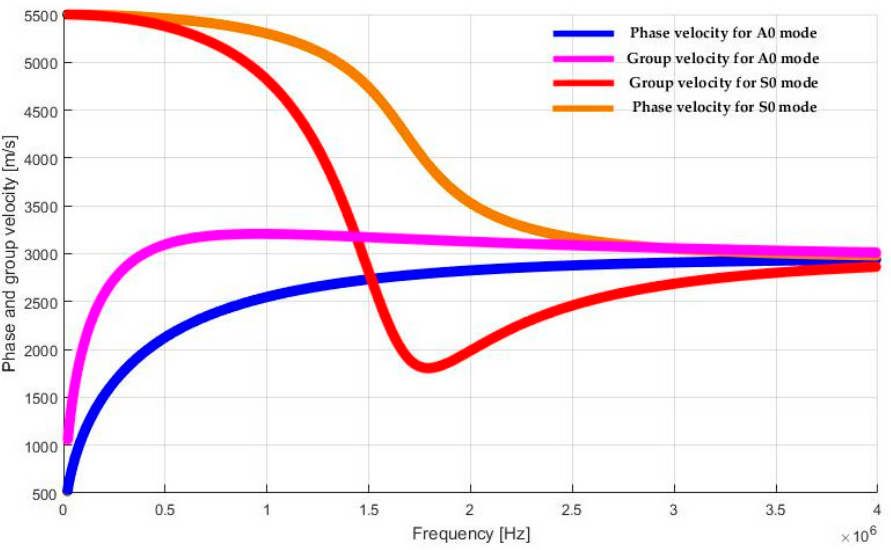
Figure 2. Dispersion curves of the group velocity (bottom) and phase velocity (top) of the 0 order modes of Lamb waves in a homogeneous aluminum plate with thickness 1.4 mm.